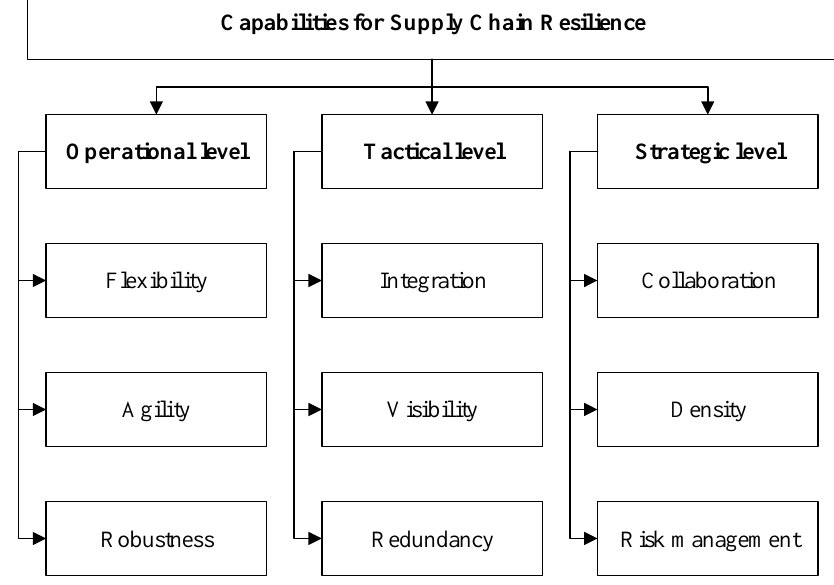
Fig. 1. Capabilities for achieving supply chain